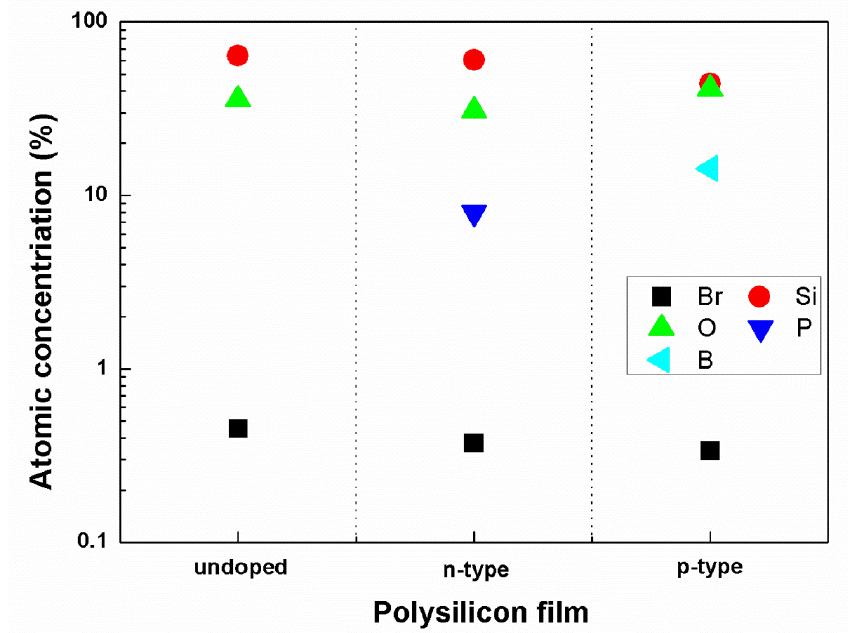
Figure 4. The compositions of three types of polysilicon film after etching measured by XPS.